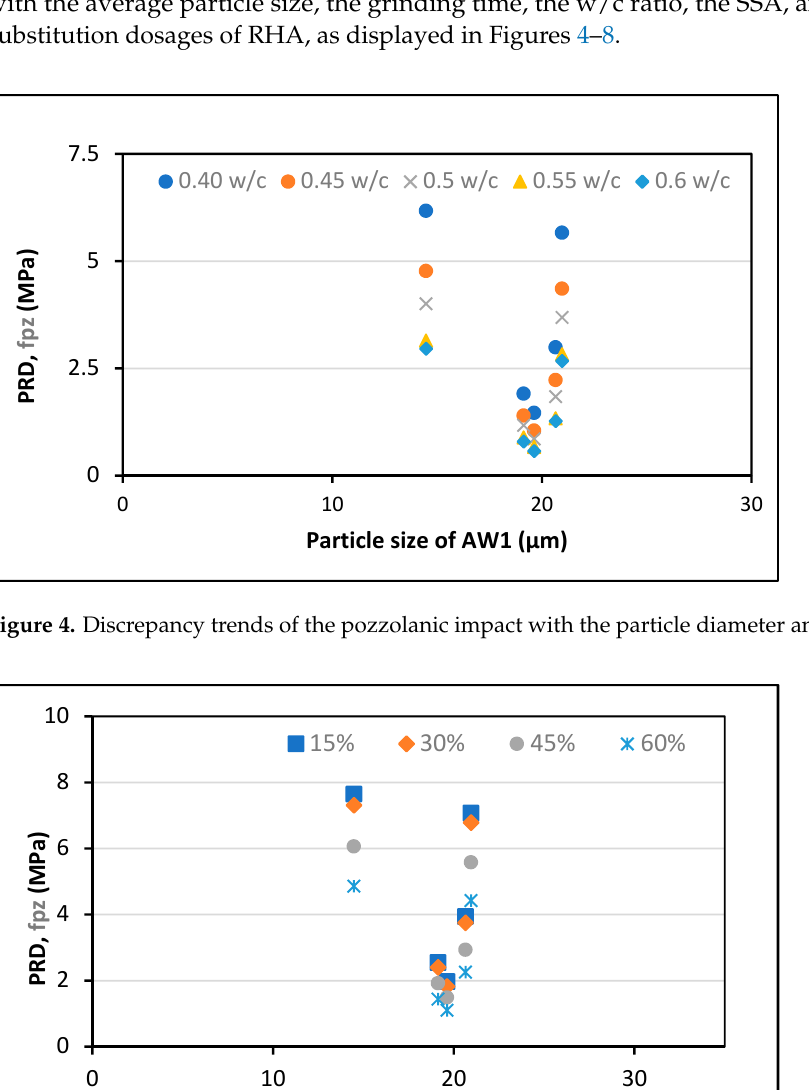
Figure 3. Relationship between the coefficient of permeability and the w/c proportion.